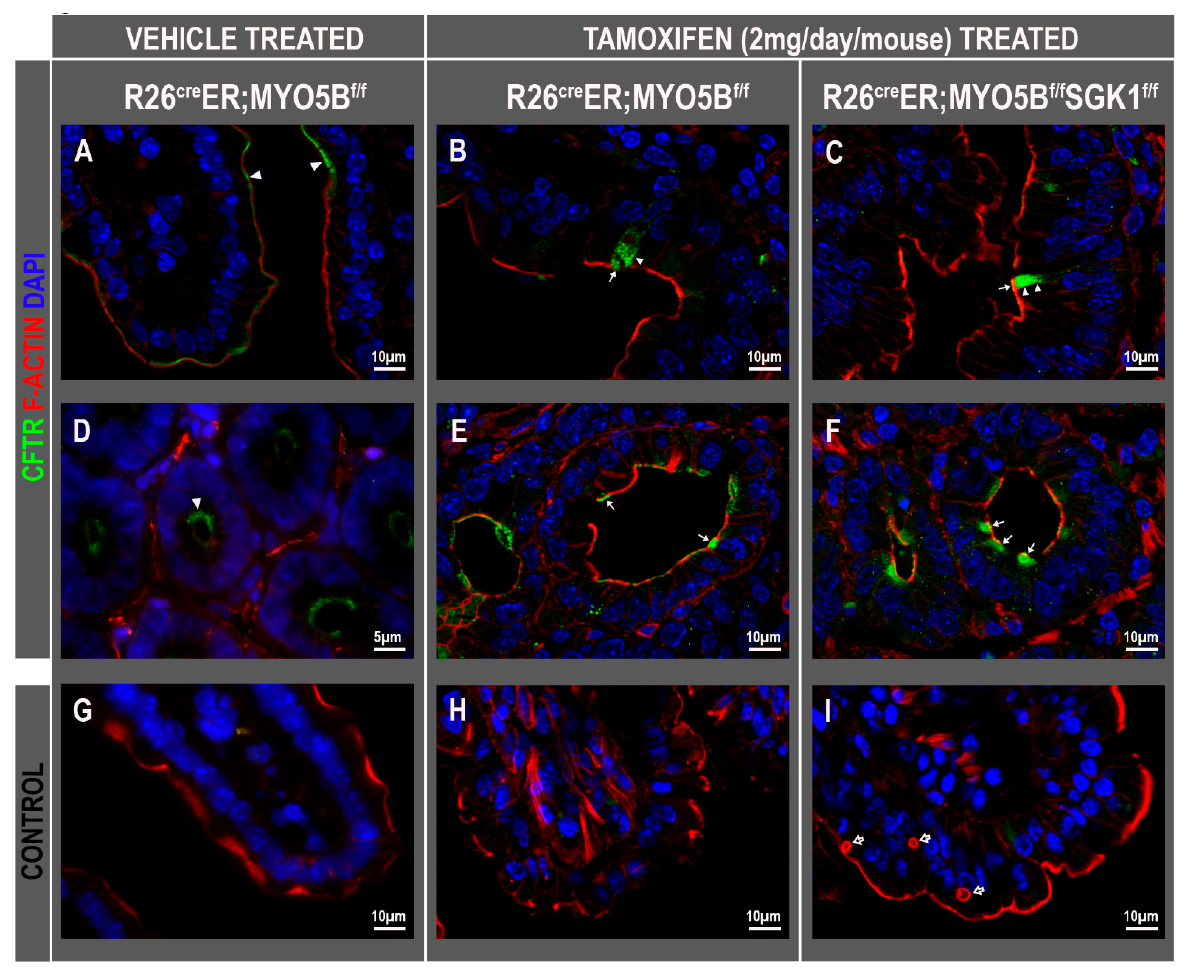
Figure 11. CFTR high expressor (CHE) cells are present in the jejunum of tamoxifen (2 mg/day/mouse for 3 days)-treated R26 Cre ER;MYO5B f/f (cMYO5BKO) and R26 Cre ER;MYO5B f/f ;SGK1 f/f (cMYO5B-SGK1-DKO) mice. Tissue sections were immunolabeled for CFTR (green), F-actin (red), and DAPI (blue). ( A , D ) Vehicle-treated R26 Cre ER;MYO5B f/f , and tamoxifen-treated ( B , E ) R26 Cre ER;MYO5B f/f (cMYO5BKO) or, tamoxifen-treated ( C , F ) R26 Cre ER;MYO5B;SGK1 f/f (cMYO5B-SGK1DKO) mice ( G – I ) are negative control staining with secondary antibody, F-actin, and DAPI. Apical and subapical localization of CFTR was found in the villus ( A ) and crypts ( D ) of vehicle-treated homozygous (arrowheads) and in CHE cells (arrows) of Tamoxifen-treated R26 Cre ER;MYO5B f/f (cMYO5BKO) ( B , E ) or R26 Cre ER;MYO5B;SGK1 f/f (cMYO5B-SGK1-DKO) ( C , F ). Arrowheads in ( B , C ) show normal subcellular localization of CFTR in CHE cells. Multiple F-actin positive microvillus inclusions (MIs) typical of MVID are shown in villus enterocytes of R26 Cre ER;MYO5B f/f SGK1 f/f (cMYO5BKO) jejunum ( I , empty arrow). Scale bars: 5 µ m and 10 µ